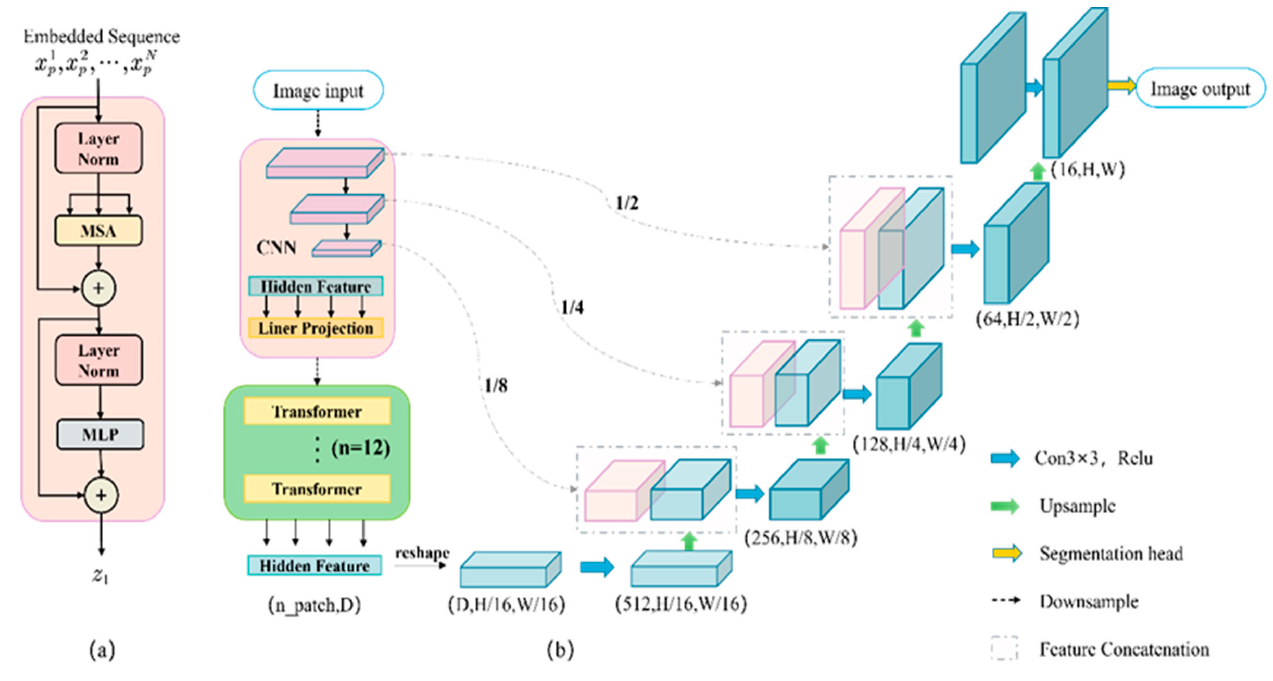
Figure 2. Framework Overview: ( a ) Transformer layer framework; ( b ) TransUNet architecture.